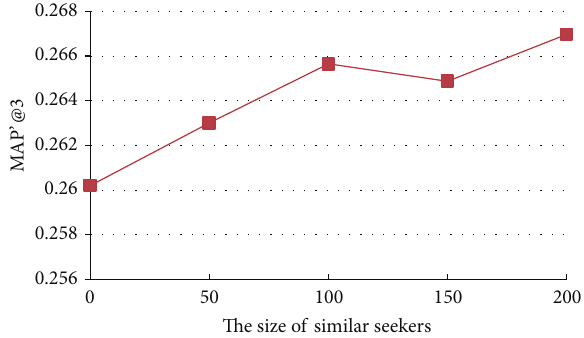
Figure 4: Impact of parameter 𝛽 on accuracy of Seeker source n model .